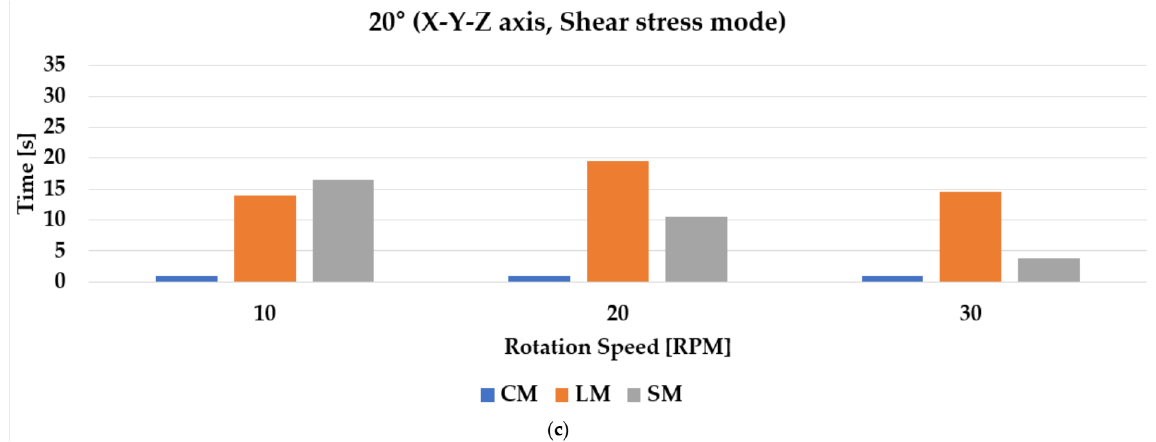
Figure 15. Specimens for testing, ( a ) 0 ◦ testing condition; ( b ) 10 ◦ testing condition, tensile stress mode; ( c ) 20 ◦ testing condition, shear stress